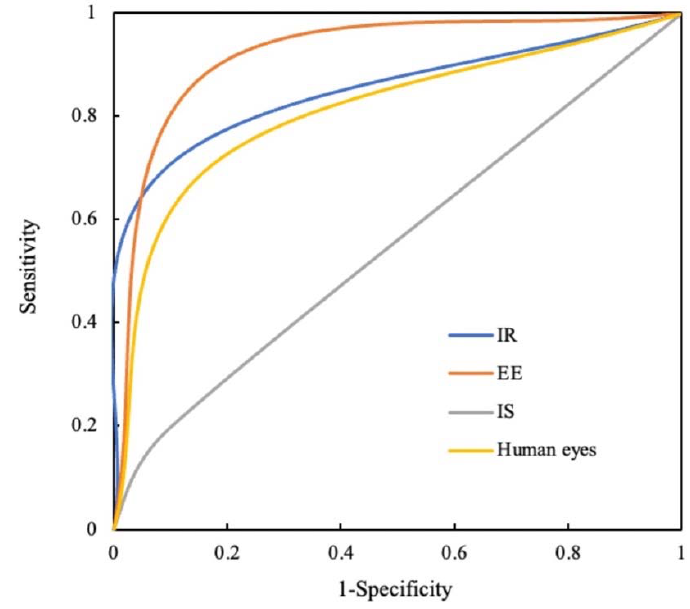
Figure 3. The ROC curves of different recognition modes and human eyes. ROC = receiver operating characteristic; IR = image recognition; EE = edge extraction; IS = image segmentation.